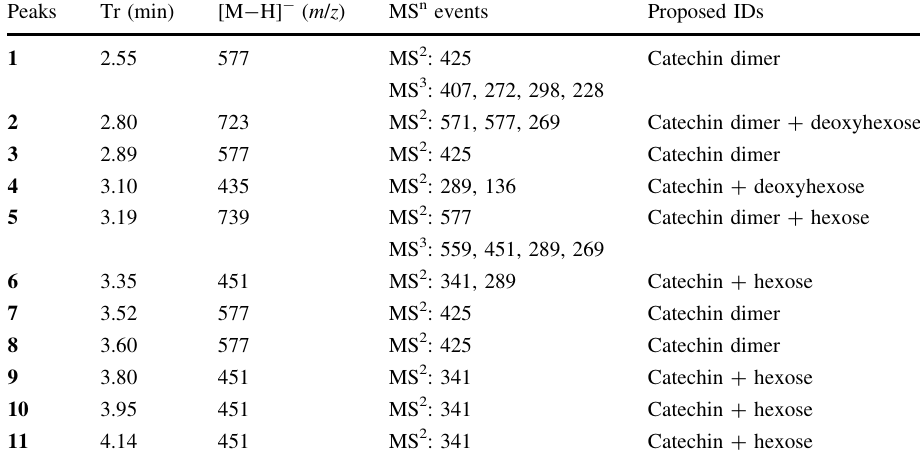
Peaks Tr (min) [M - H] - ( m / z ) MS n